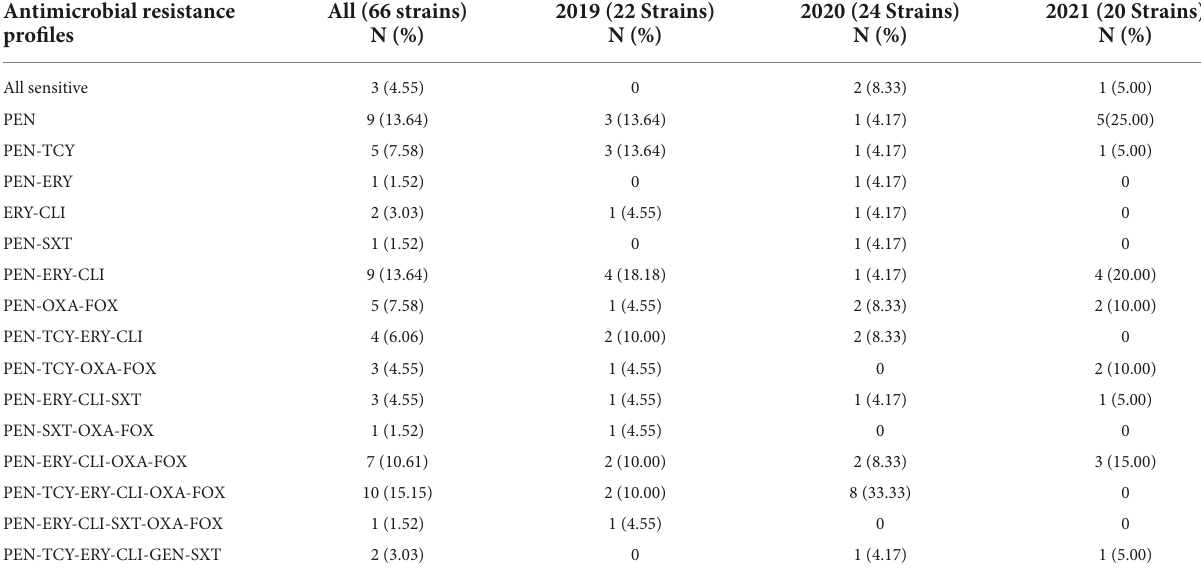
TABLE 4 Antimicrobial resistance profiles of invasive Staphylococcus aureus strains from 2019 to 2021. Antimicrobial resistance profiles